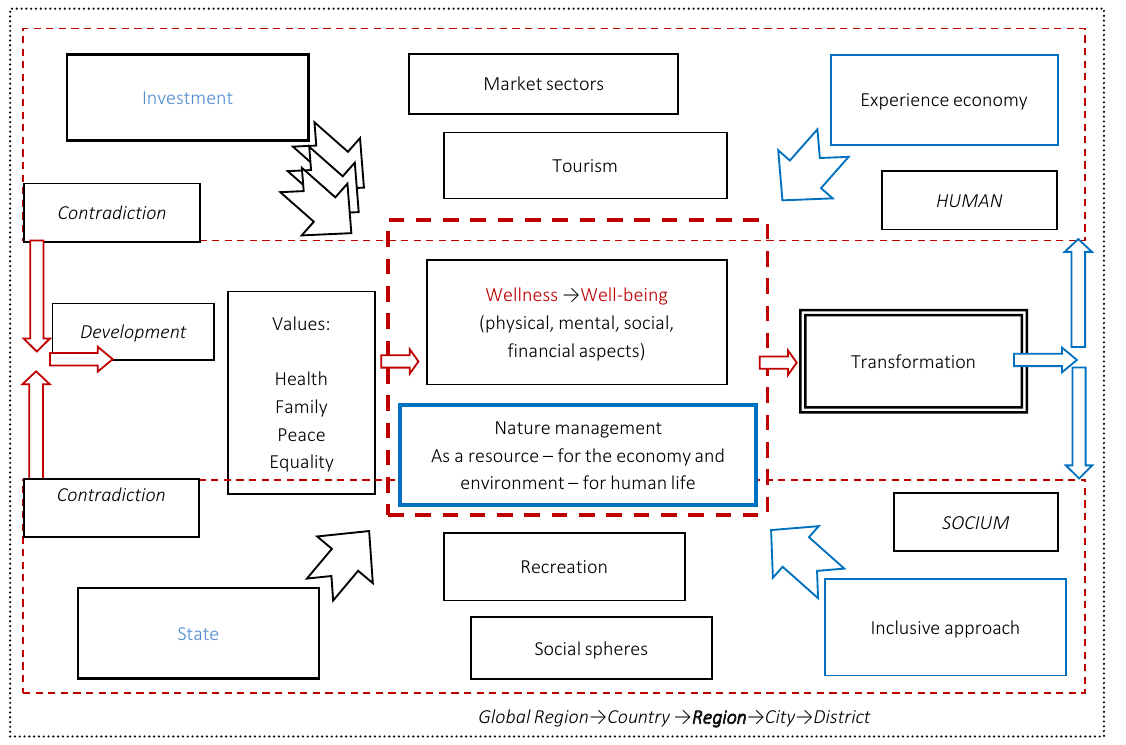
Figure 2. Conceptual scheme for long-term attraction of investment in inclusive wellness and